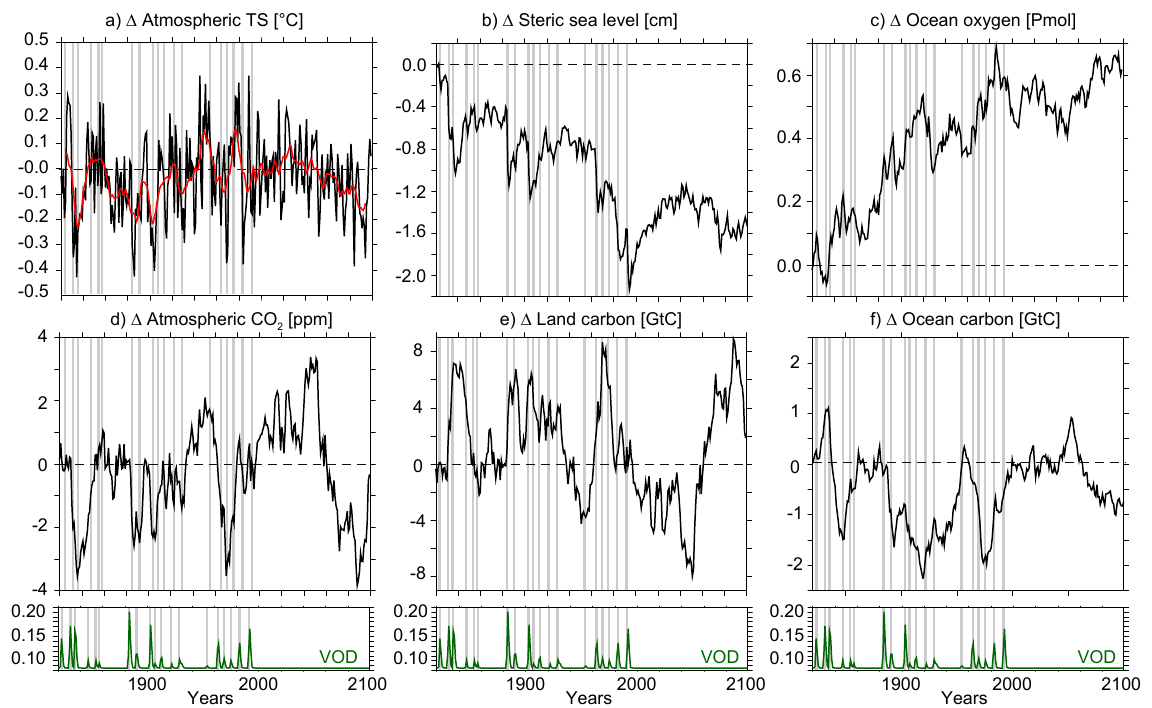
Fig. 13. Differences in global annual mean (a) atmospheric surface temperature, (b) steric sea level, (c) ocean oxygen inventory, (d) atmospheric CO 2 , (e) land carbon inventory, and (f) ocean carbon inventory between a simulation with and a simulation without volcanic eruptions over the period 1820 to 2099. (Bottom) Volcanic forcing expressed as aerosol optical depth changes in the mid-visible wavelength (VOD). The gray shaded bands indicate different historical explosive volcanic eruptions. No volcanic eruptions are assumed for the period 2000 to 2099. Dashed lines show the zero-line as reference. Red line in (a) shows the 10-yr running mean of atmospheric surface temperature differences to highlight decadal changes.